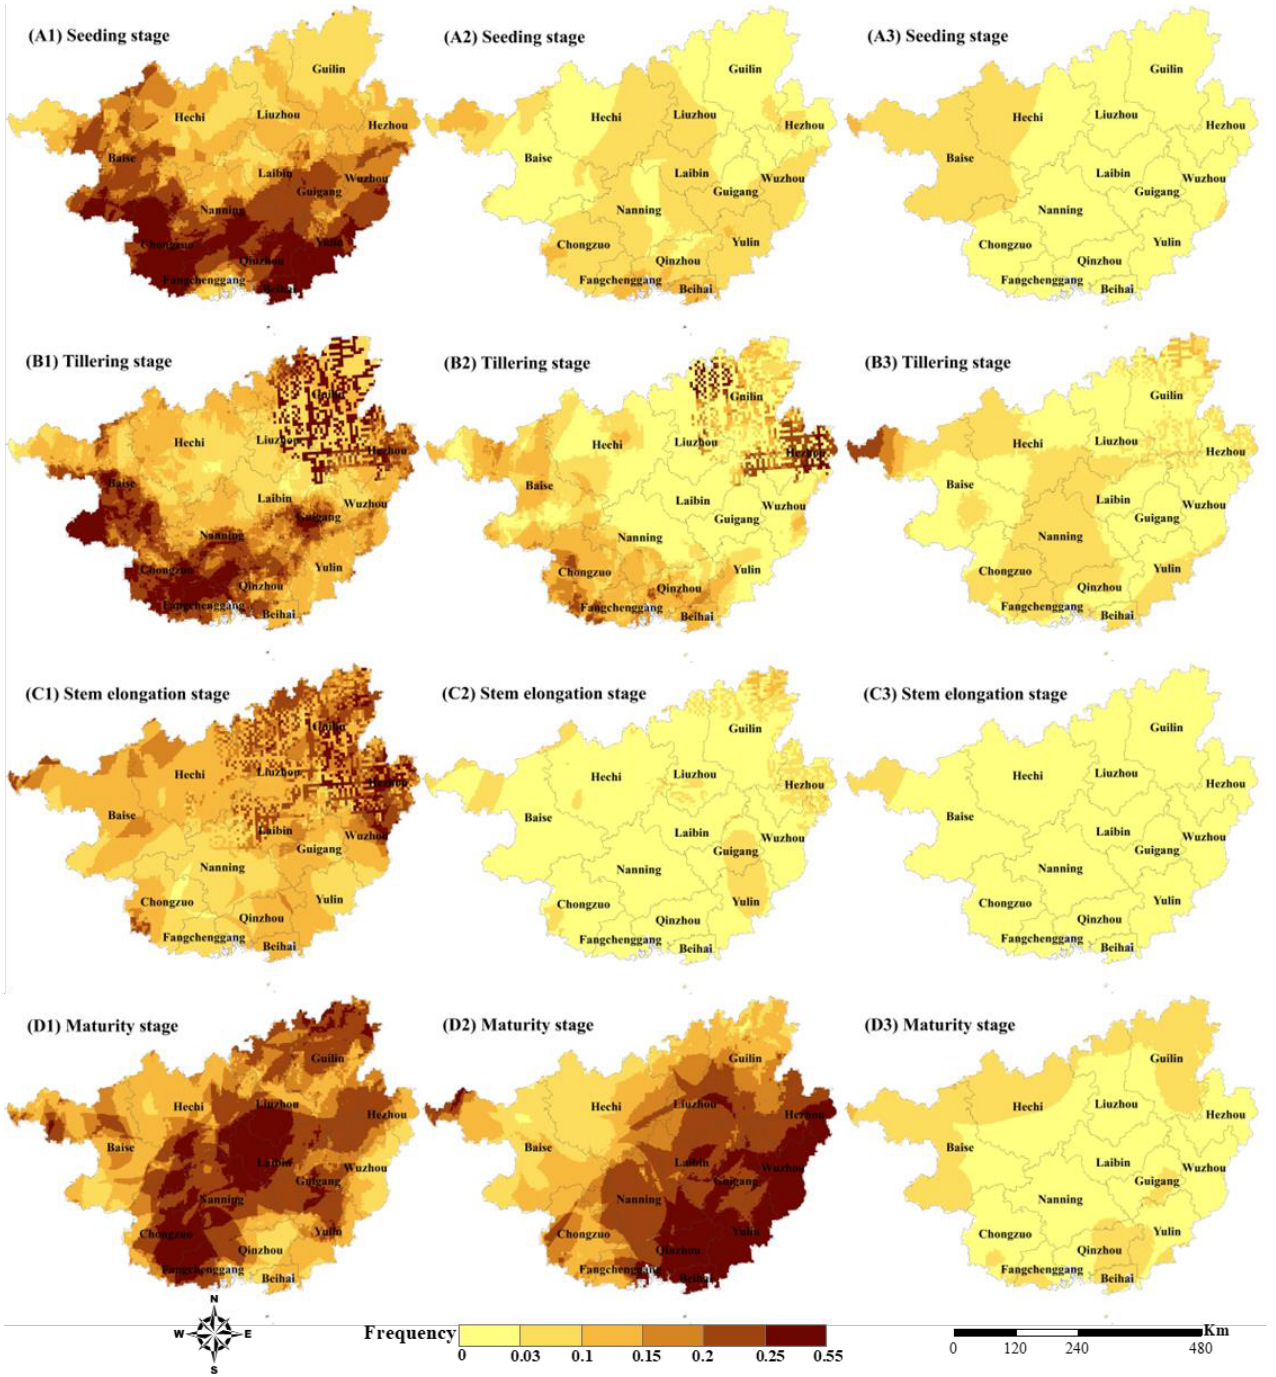
Figure 5. Spatial distribution of the frequency of the different drought classes in the four growth stages of sugarcane based on CDI : ( A – D ) show the stages of seedling, tillering, stem elongation, and maturity, respectively; and ( 1 – 3 ) represent the light, moderate, and severe drought intensities for sugarcane, respectively.